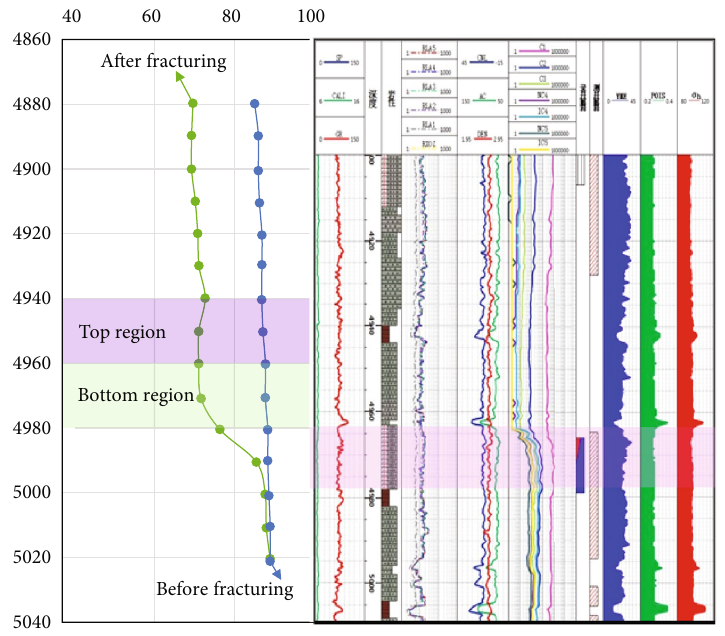
Figure 8: Well temperature monitoring curve of a well in Mahu before and after